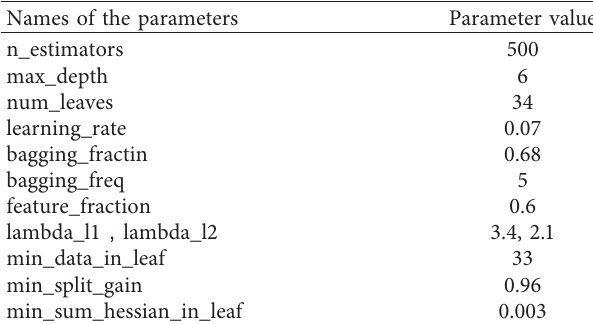
Table 2: Value of important parameters of